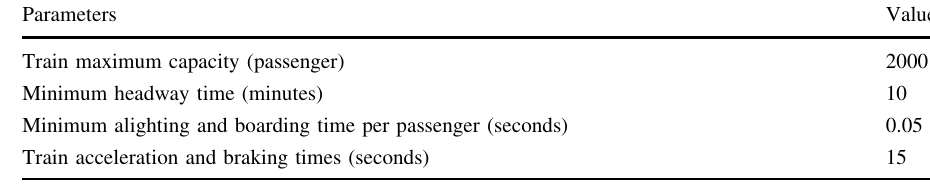
Table 2 Parameters values and related units used in the case study